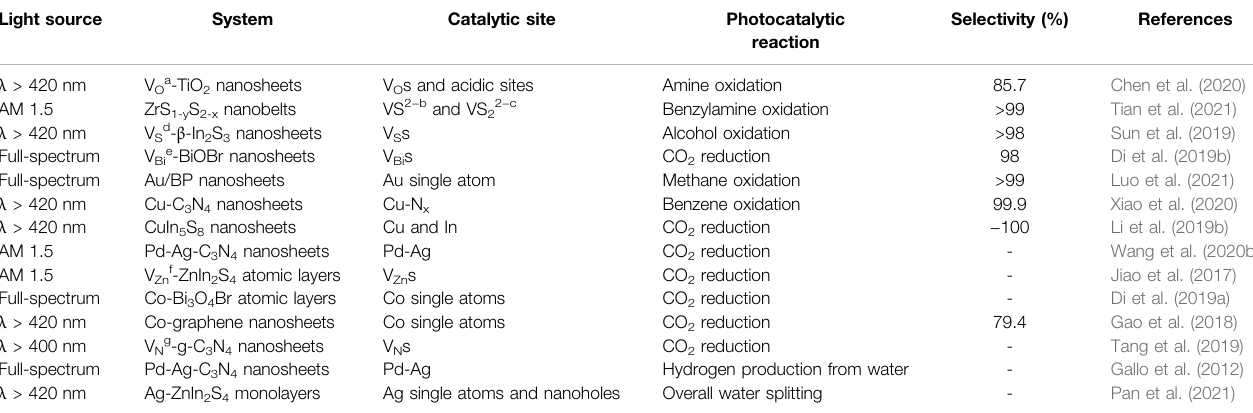
TABLE 1 | Comparison of 2D semiconductor photocatalysts with atomically sur fi cial modulation for selective photocatalytic